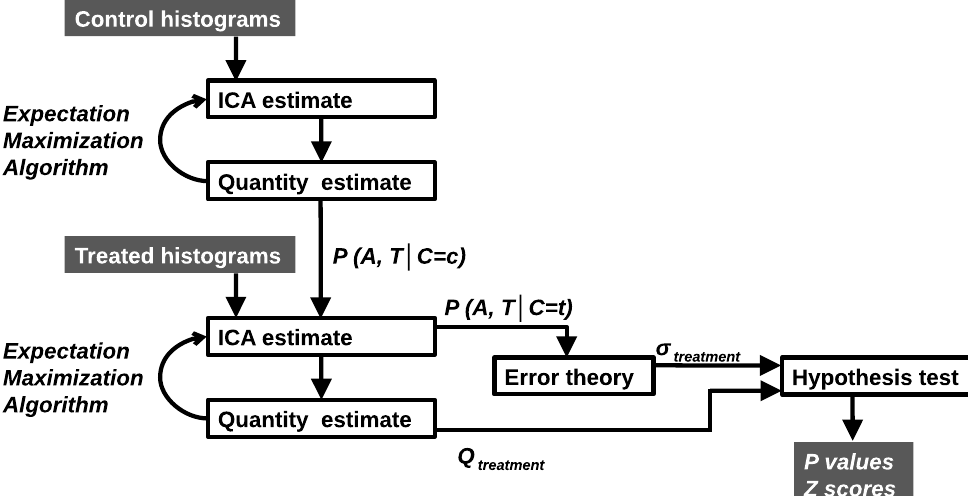
Figure 2. Control histograms are deconstructed giving components describing untreated behaviour. Histograms are added to create additional components to describe treated behaviour. All components are combined with Bayes Theorem to give per bin, per time point (A, T) probabilities of classification (C = c control or C = t treatment). The error theory is used to produce hypothesis tests for the significance of treatment